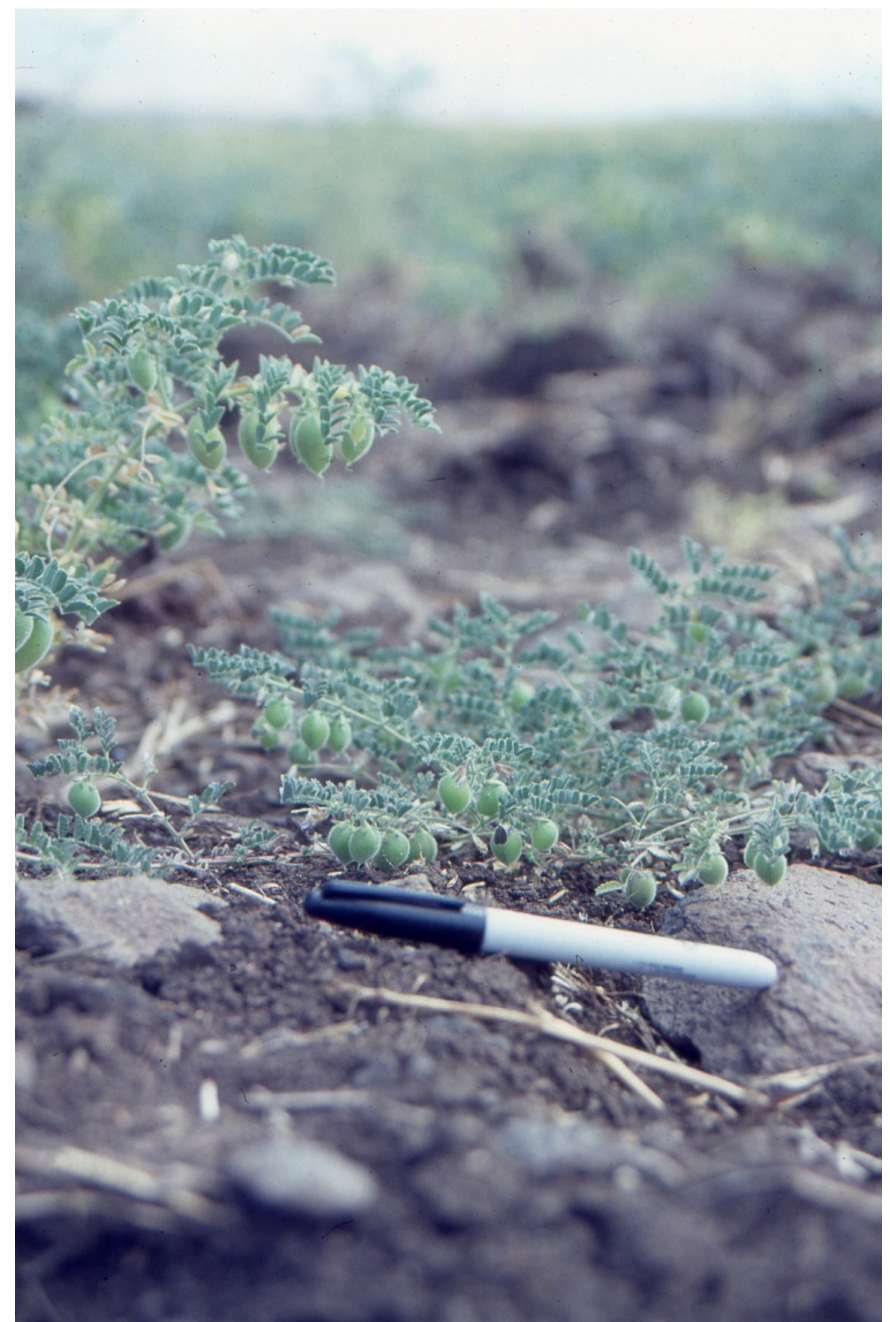
Figure 1. Wild C. echinospermum (right) with prostrate growth habit alongside domesticated (left, erect) chickpea near Siverek, southeast Turkey, June 2002 (photo by S.